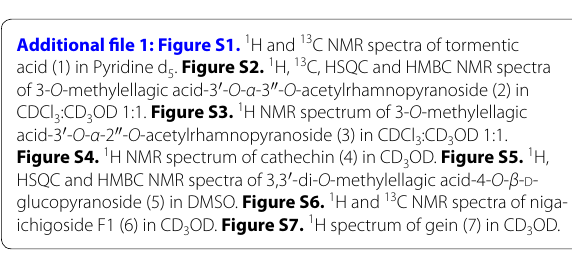
Figure S4. 1 H NMR spectrum of cathechin (4) in CD 3 OD. Figure S5. 1 H, HSQC and HMBC NMR spectra of 3,3 ′ -di- O -methylellagic acid-4- O - β - d